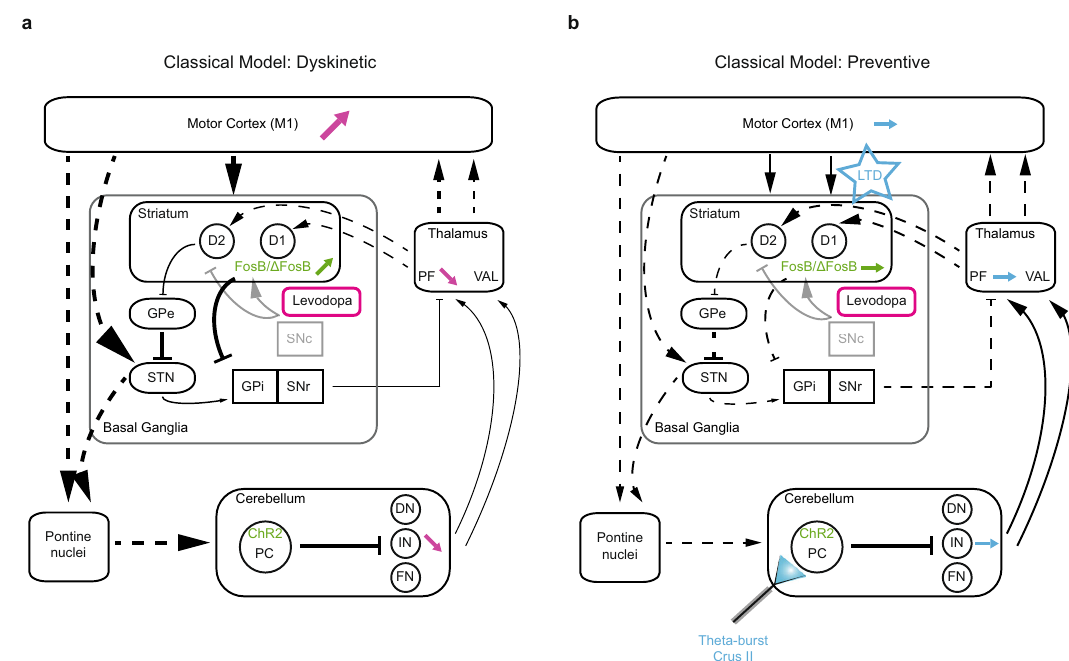
Fig. 8 Preventive PC stimulations normalize aberrant activity in the cerebello-thalamo-striatal pathway associated to dyskinesia. Schematic representation of the cerebello-thalamo-cortical, cerebello-thalamo-striatal, and basal ganglia-thalamo-cortical pathways and their modulations observed in dyskinetic ( a ) and preventive mice ( b ). Schematic representation of the cerebello-thalamo-cortical, cerebello-thalamo-striatal, and basal ganglia- thalamo-cortical pathways and their modulations in ( a ) levodopa-induced dyskinesia (magenta arrows) and ( b ) in preventive mice (blue arrows). Green arrows represent modulations of expression in FosB/ Δ FosB in the dorsolateral striatum, black arrows represent excitatory projections, and blunted arrows represent inhibitory connections. Dotted lines represent unknown interactions, thick lines represent increased output, and thin lines represent decreased output. Faded projections represent the loss of the pathway. D1: D1-expressing striatal projection neurons; D2: D2-expressing striatal projection neurons; GPe globus pallidus pars externus; GPi globus pallidus pars internus; SNc substantia nigra pars compacta; SNr substantia nigra pars reticulata; STN subthalamic nucleus; VAL ventroanterior-ventrolateral complex of the thalamus; PF parafascicular nucleus of the thalamus; M1: primary motor cortex; PC Purkinje cells; DN dentate cerebellar nucleus; IN interposed cerebellar nucleus; FN fastigial cerebellar nucleus; LTD long-term depression. Adapted from 5